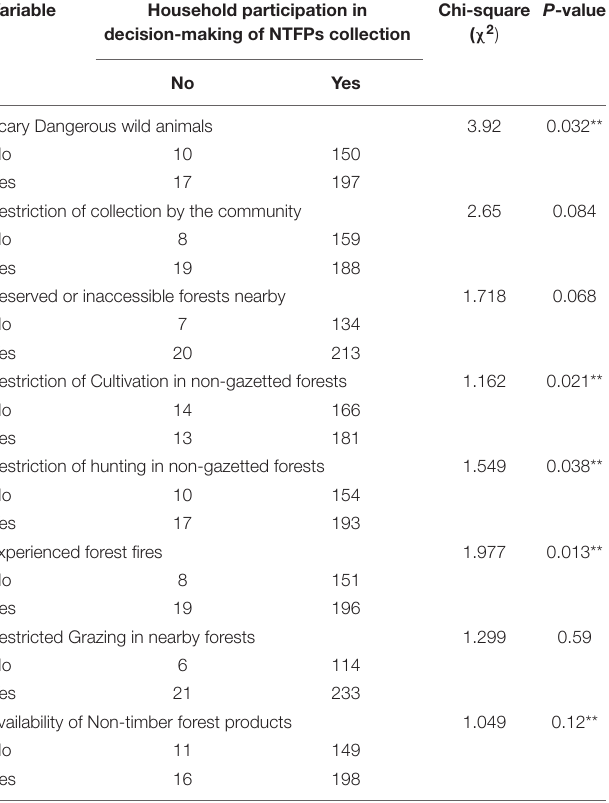
TABLE 1 | Psychical factors characterizing the dependence on non-timber forest products. Variable Household participation in decision-making of NTFPs collection